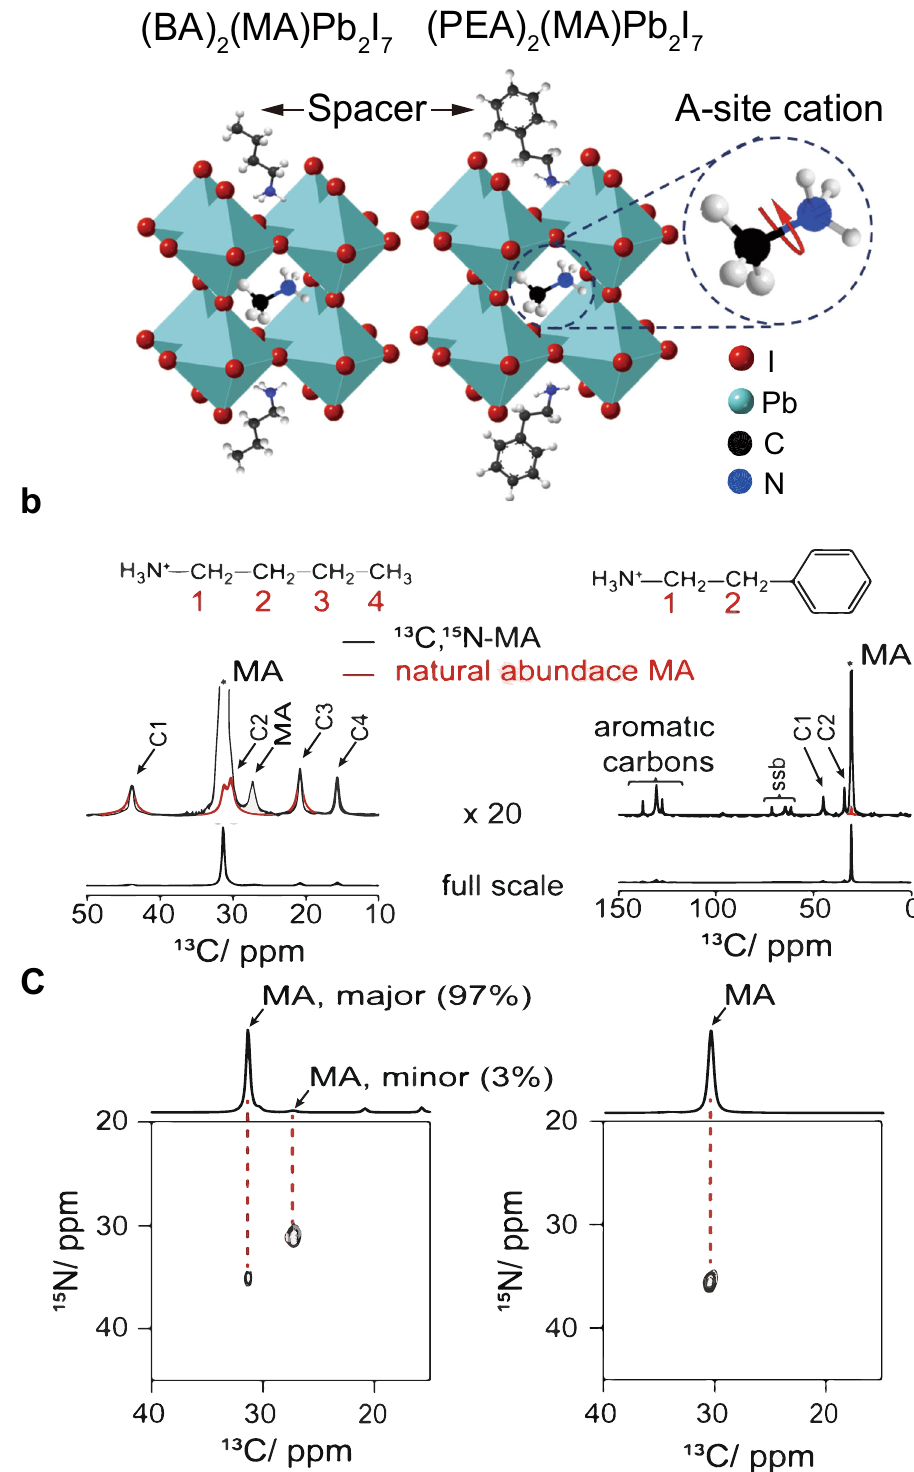
Fig. 1 13 C NMR spectral characterisation of 2D OIHP crystals ( n = 2). a The structural models of 2D (BA) 2 (MA)Pb 2 I 7 ( n = 2) and 2D (PEA) 2 (MA)Pb 2 I 7 ( n = 2). b The 13 C CPMAS spectra of 2D (BA) 2 (MA)Pb 2 I 7 ( n = 2) and 2D (PEA) 2 (MA)Pb 2 I 7 ( n = 2) synthesised with 13 C, 15 N-MA, respectively. The spectra with ×20 magni fi cation are shown on the top, overlayed with the spectra of the materials synthesised with natural-abundance MA. The two sets of spectra have been normalised by the height of the C1 carbon peak of BA and the aromatic carbon peak at 130.7 ppm, respectively. c 2D DCP MAS ( 13 C, 15 N) correlation spectra of 2D (BA) 2 ( 13 C, 15 N-MA)Pb 2 I 7 ( n = 2) and 2D (PEA) 2 ( 13 C, 15 N-MA)Pb 2 I 7 ( n = 2), respectively. The 13 C direct excitation MAS NMR spectra are overlayed on the